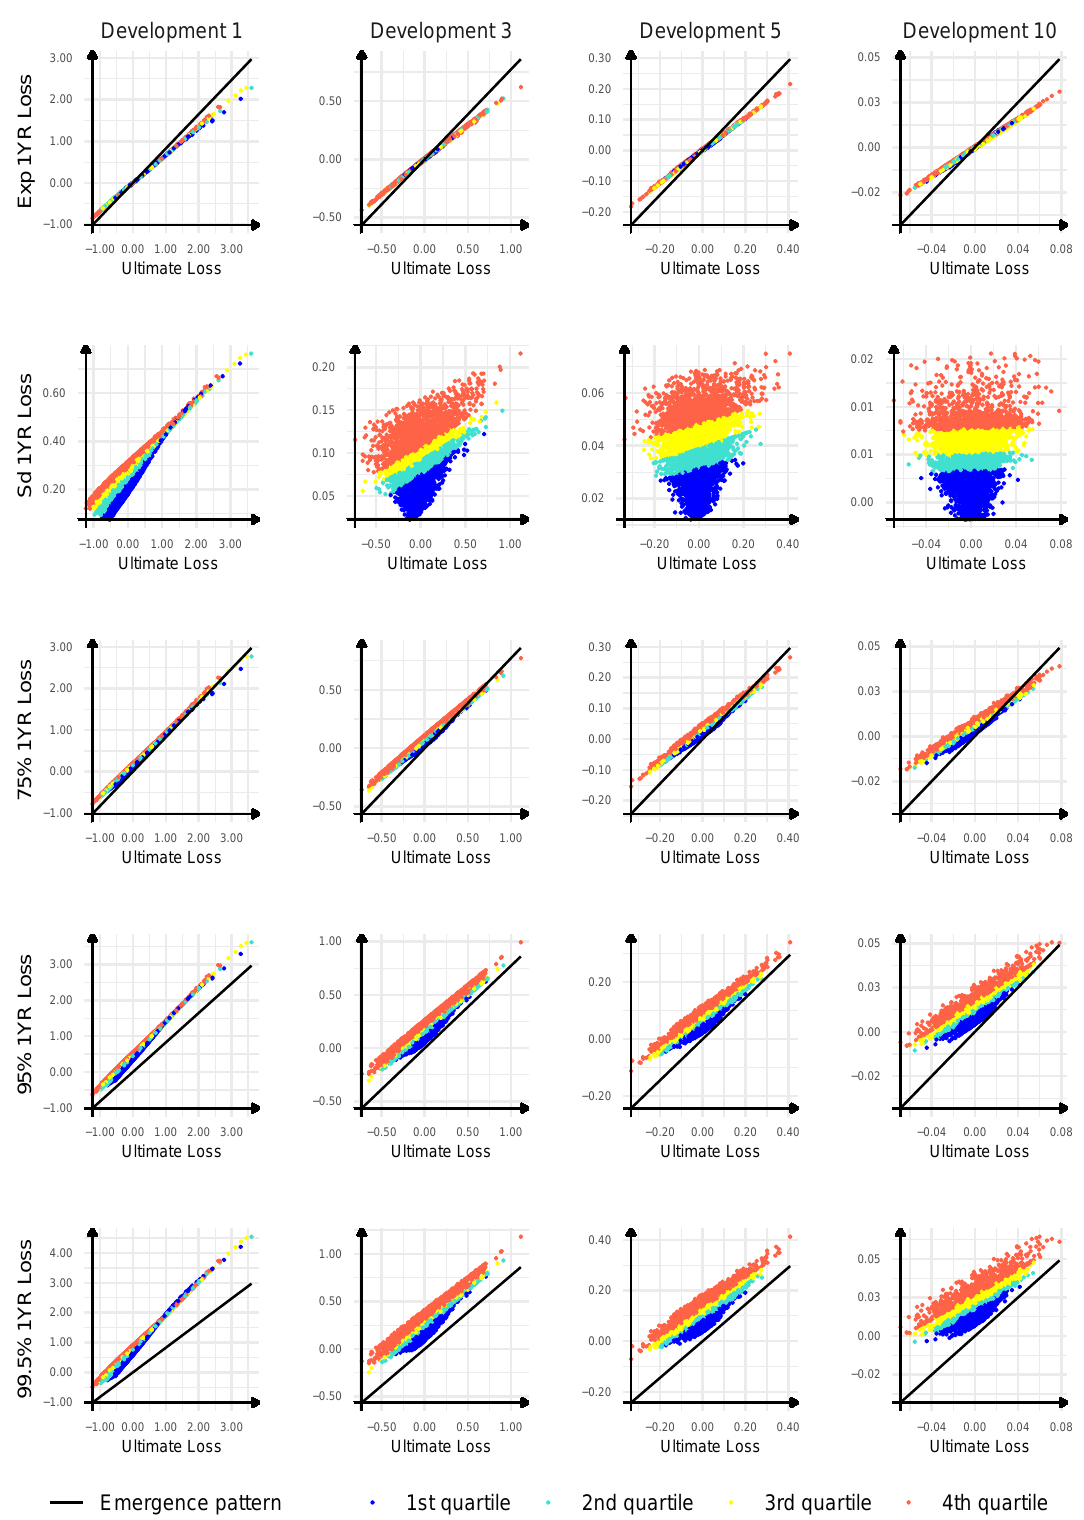
Figure 2. The true emergence pattern and the linear emergence pattern of the one-year loss—the case without the estimation